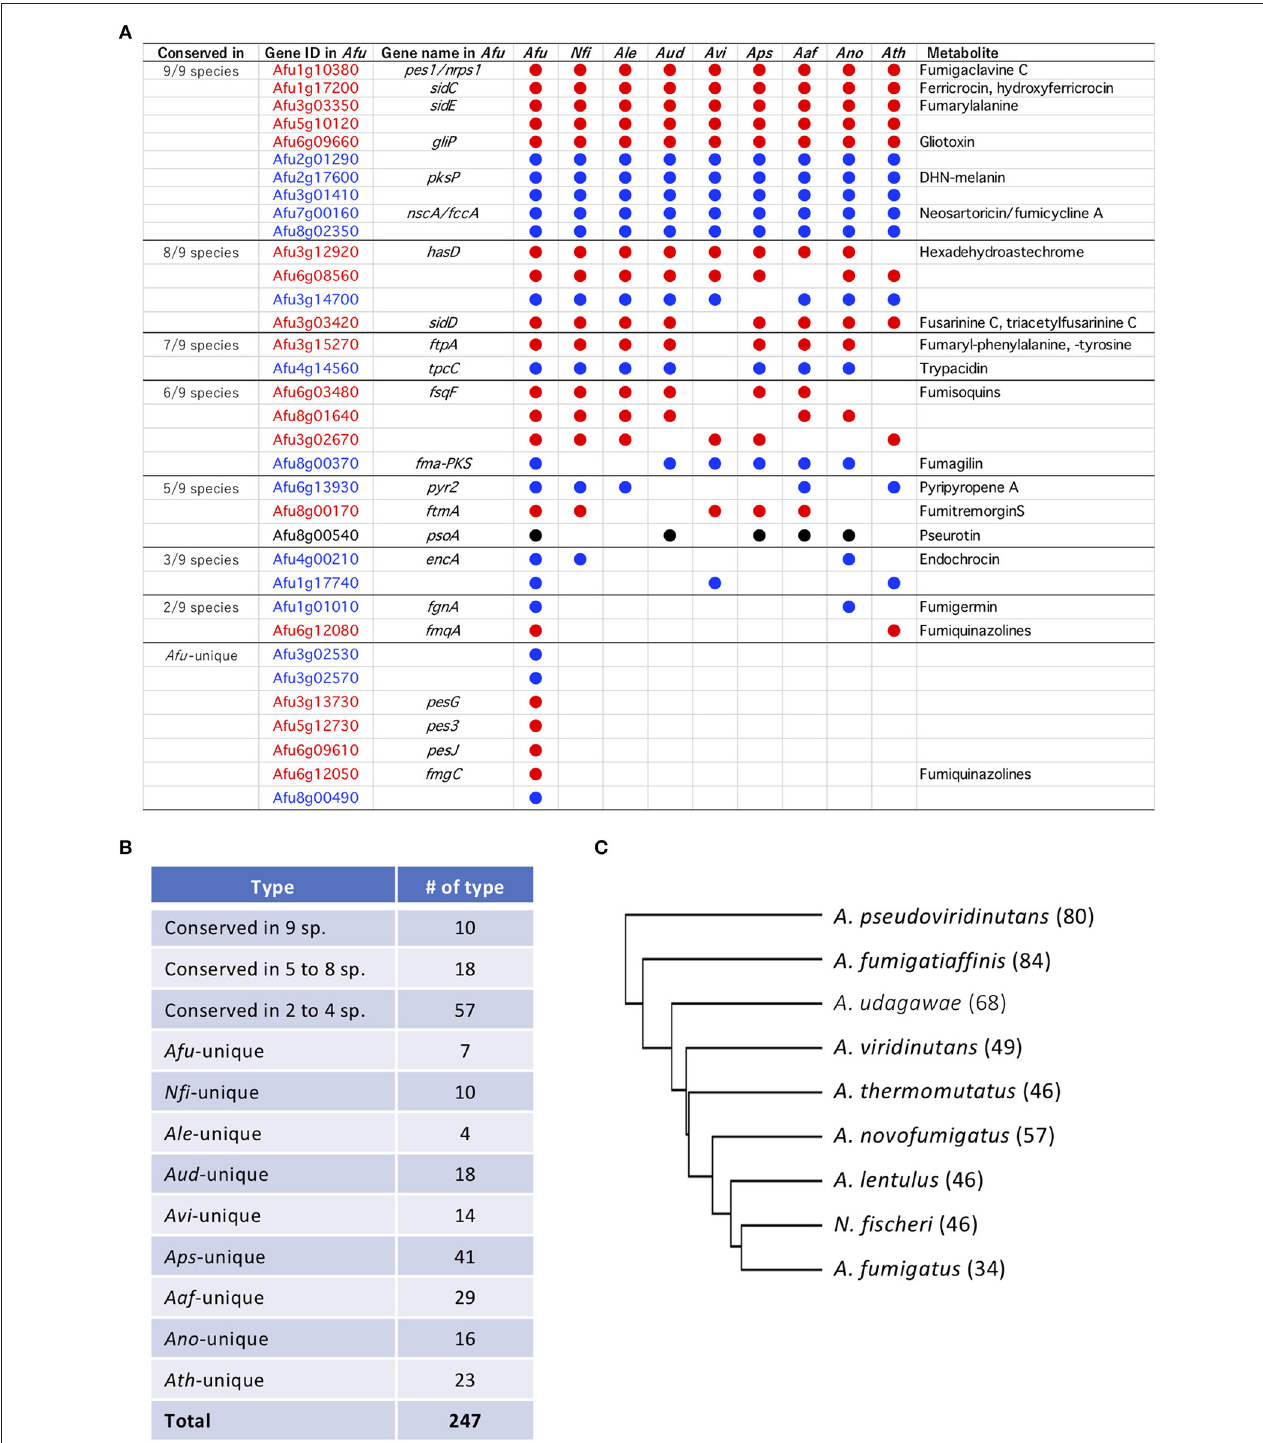
FIGURE 2 | Secondary metabolite (SM) backbone genes conserved across Aspergillus section Fumigati . (A) Summary of A. fumigatus SM backbone genes. Some are conserved in other Fumigati species. Afu, A. fumigatus; Nfi, Neosartorya fischeri; Ale, A. lentulus; Aud, A. udagawae; Avi, A. viridinutans; Aps, A. pseudoviridinutans; Aaf, A. fumigatiaffinis; Ano, A. novofumigatus; Ath, A. thermomutatus . (B) Summary of the numbers of SM gene types. (C) A cladogram was constructed using a binary matrix (presence/absence of the PKSs and NRPSs) with Cluster 3.0. The tree was constructed and drawn using Tree View. The numbers of SM backbone genes are shown in parentheses behind the species